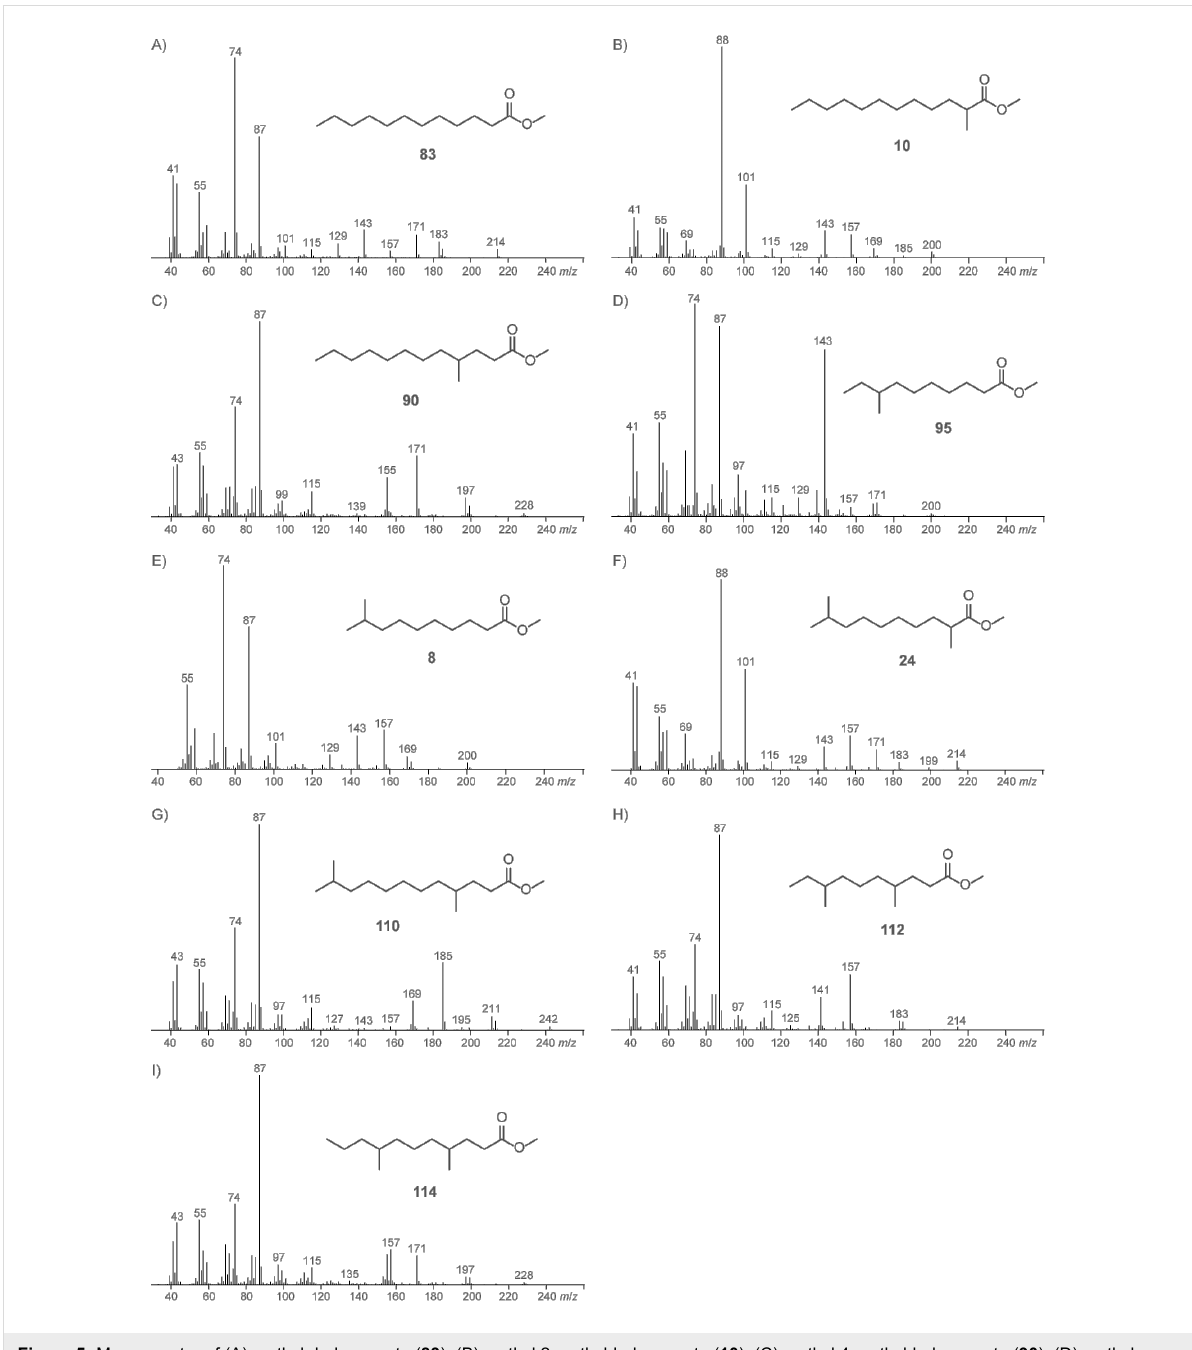
Figure 5: Mass spectra of (A) methyl dodecanoate ( 83 ), (B) methyl 2-methyldodecanoate ( 10 ), (C) methyl 4-methyldodecanoate ( 90 ), (D) methyl 8-methyldecanoate ( 95 ), (E) methyl 9-methyldecanoate ( 8 ), (F) methyl 2,9-dimethyldecanoate ( 24 ), (G) methyl 4,11-dimethyldodecanoate ( 110 ), (H) methyl 4,8-dimethyldecanoate ( 112 ), and (I) methyl 4,8-dimethylundecanoate ( 114 ).